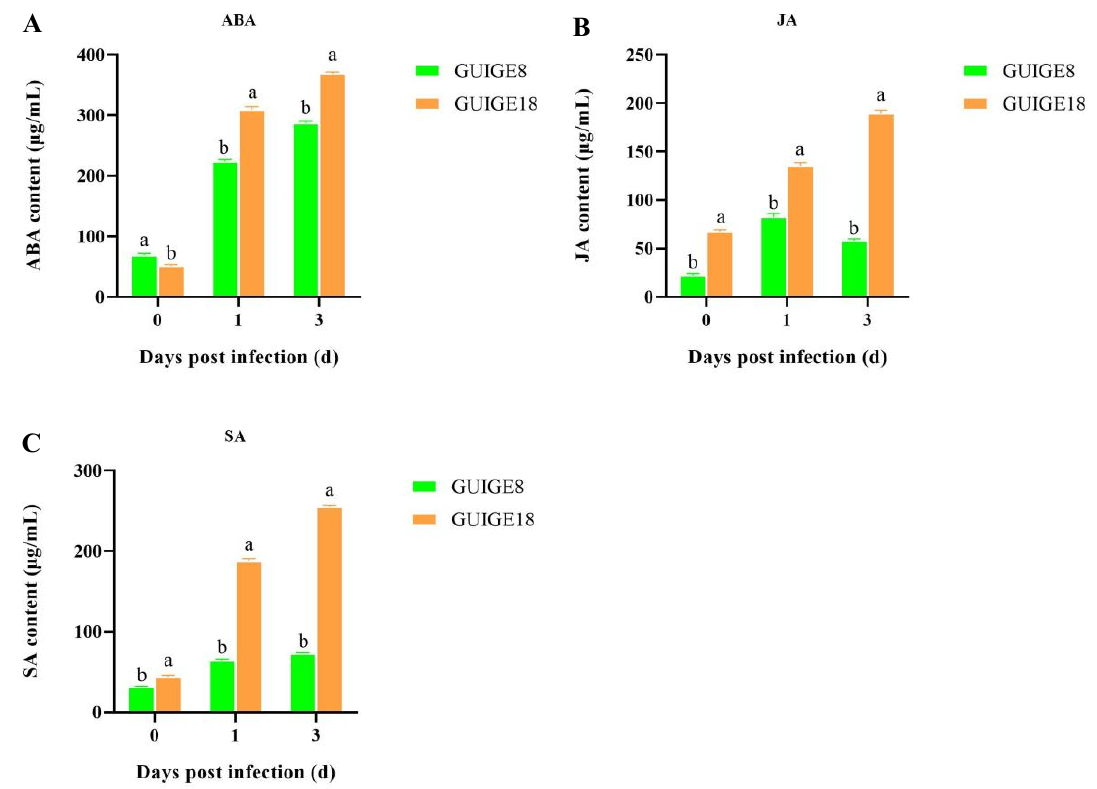
Figure 7. The endogenous hormone content across three time points (0, 1, and 3 days) after SpM infection in resistant (GUIGE18) and susceptible cultivars (GUIGE8). ( A ) Abscisic acid (ABA); ( B ) jasmonic acid (JA); ( C ) salicylic acid (SA). Letters ‘a/b’ indicate difference changes between the two cultivars on the same day ( p < 0.05), according to Duncan’s multiple range test using SPSS software.